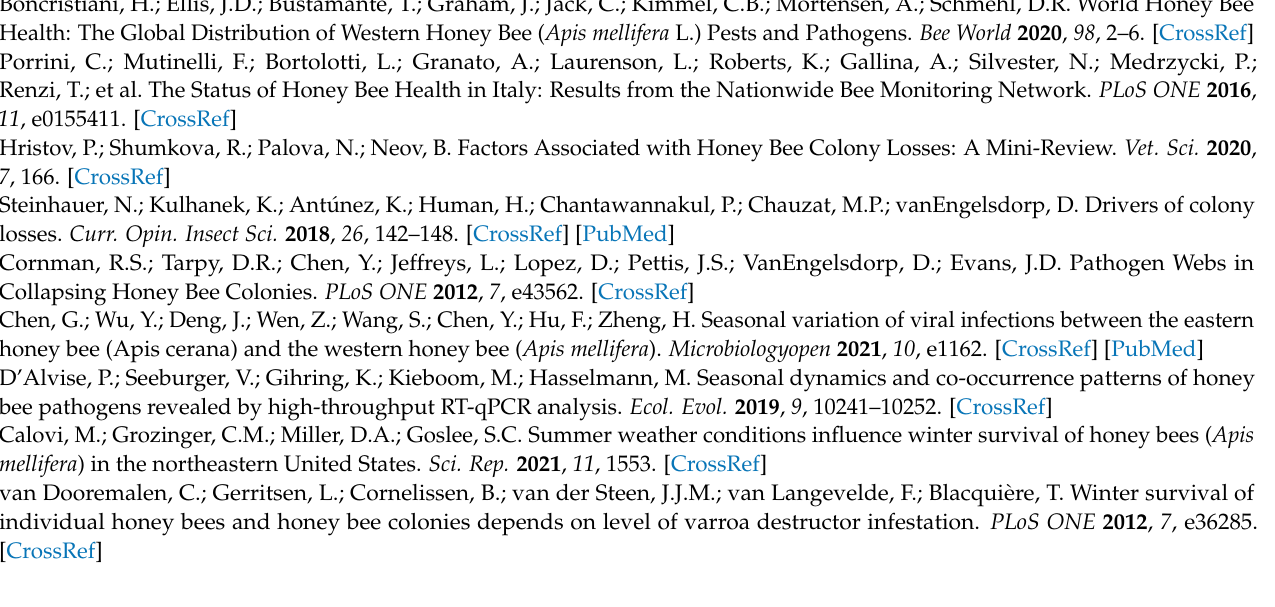
Table S2. The mean annual abundance of DWV, KBV, ABPV, CBPV and N. ceranae in the investi- gated apiary. Table S3. p values resulting from the post-hoc Dunn’s test for pairwise comparisons (ns =